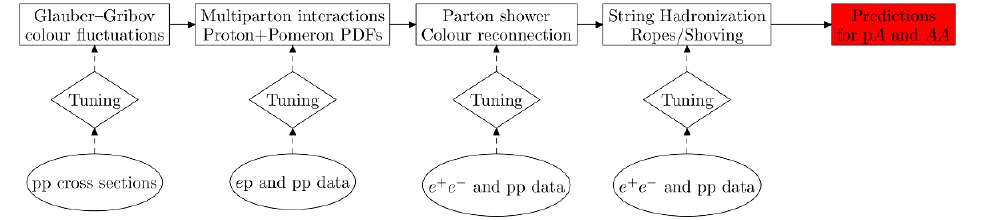
Figure 1 . Flowchart showing the programmatic structure of Angantyr. In order to make predic- tions for heavy ion collisions, several parts of a normal P YTHIA 8 simulation needs to be modi(cid:12)ed, and tuned accordingly. In the (cid:13)owchart we illustrate how each separate part is tuned to either e + e (cid:0) , ep or pp data, while no tuning is done to heavy ion